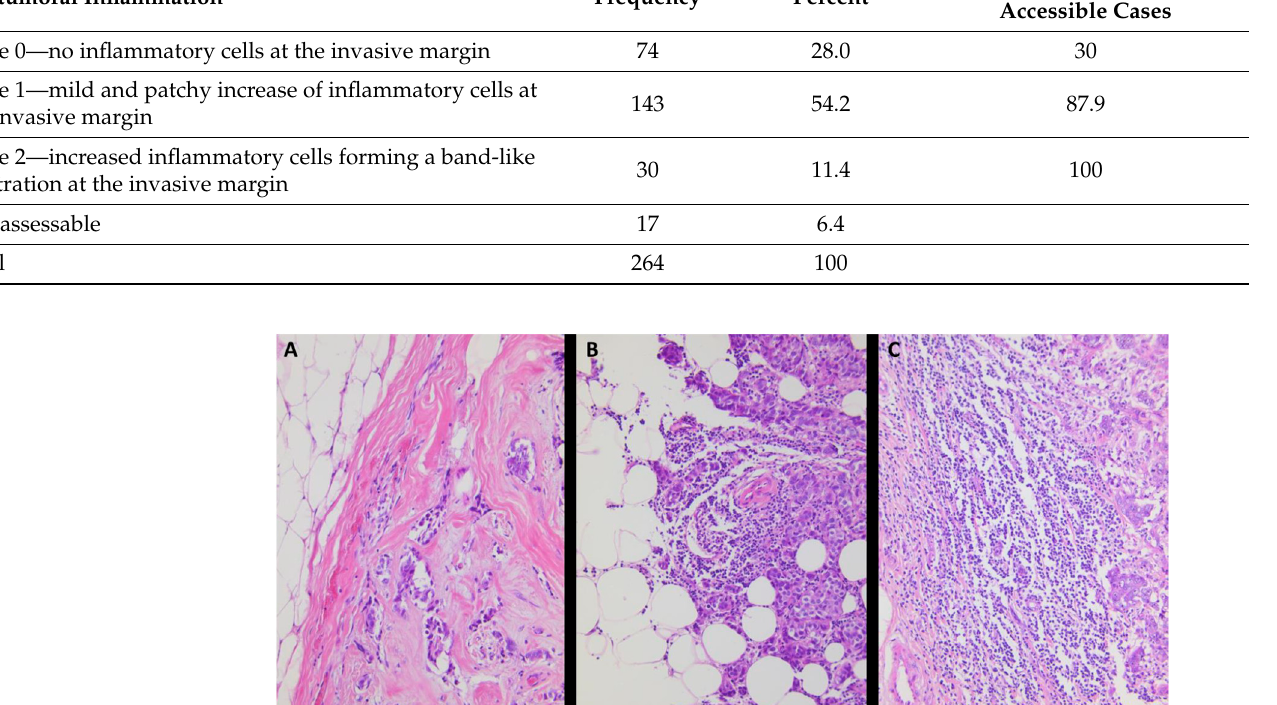
Table 4. Quantification of peritumoral inflammation according to the Klintrup score.